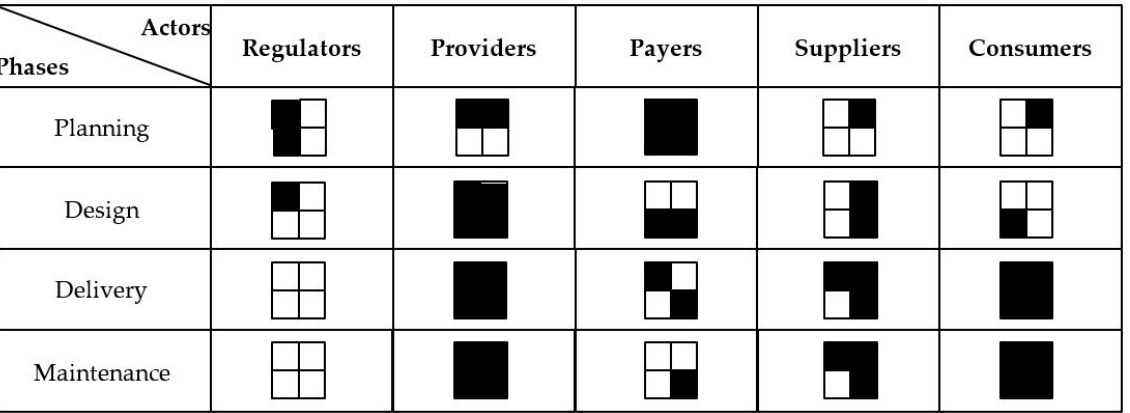
Figure 1. Cocreation in studied cases. Key: the number of black squares represents the number of appearances in all the cases. The left upper square symbolises case #1, right upper-case #2, etc. ⬛ —appearance in a given case. Source: own elaboration.